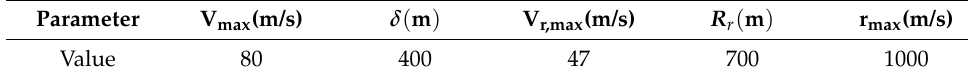
Table 1. Main parameters adopted in the simulation of downbursts.